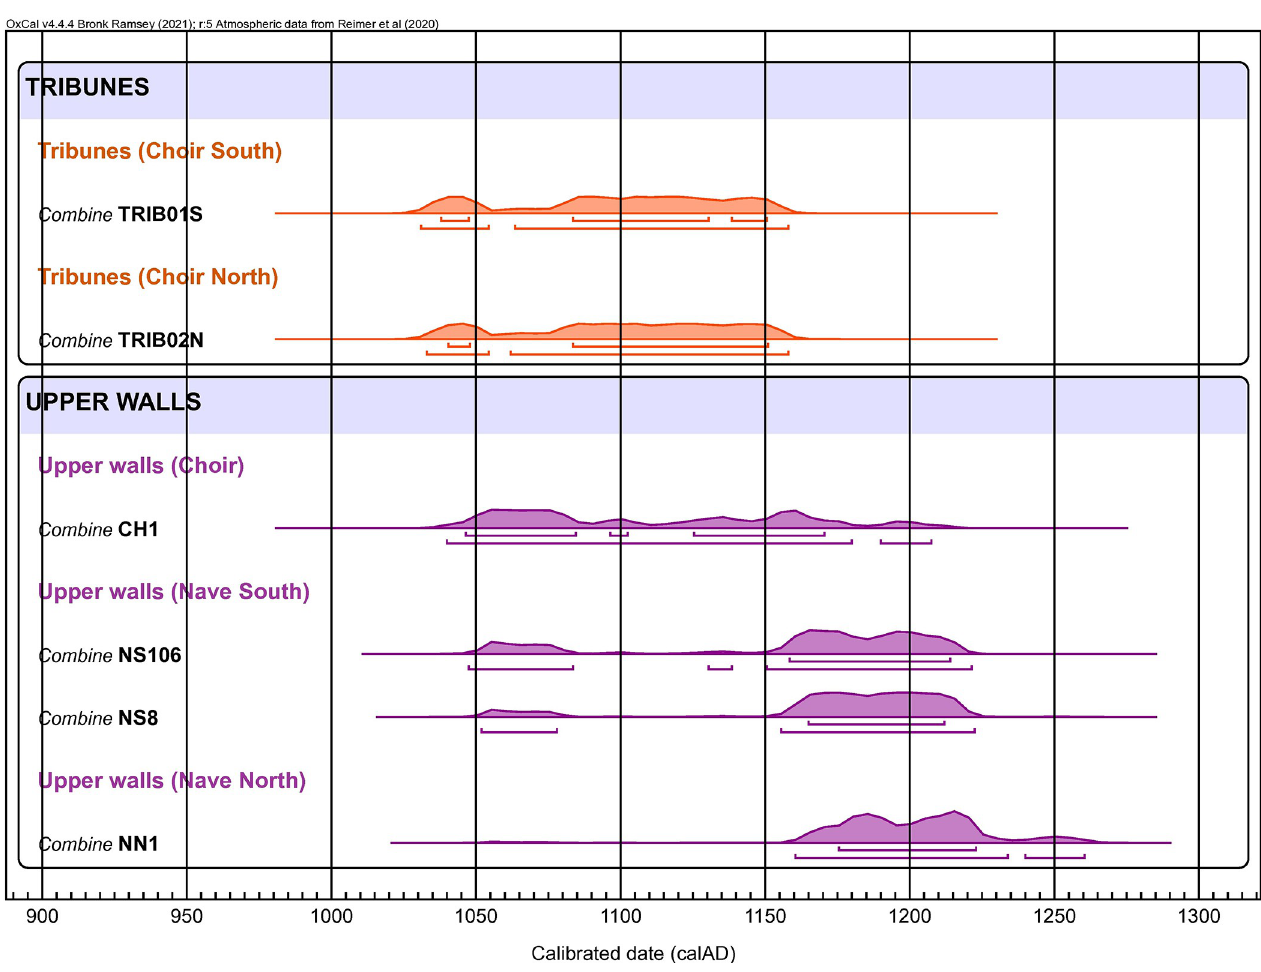
Fig 13. Comparison of radiocarbon dating of the staples of the tribunes and the upper